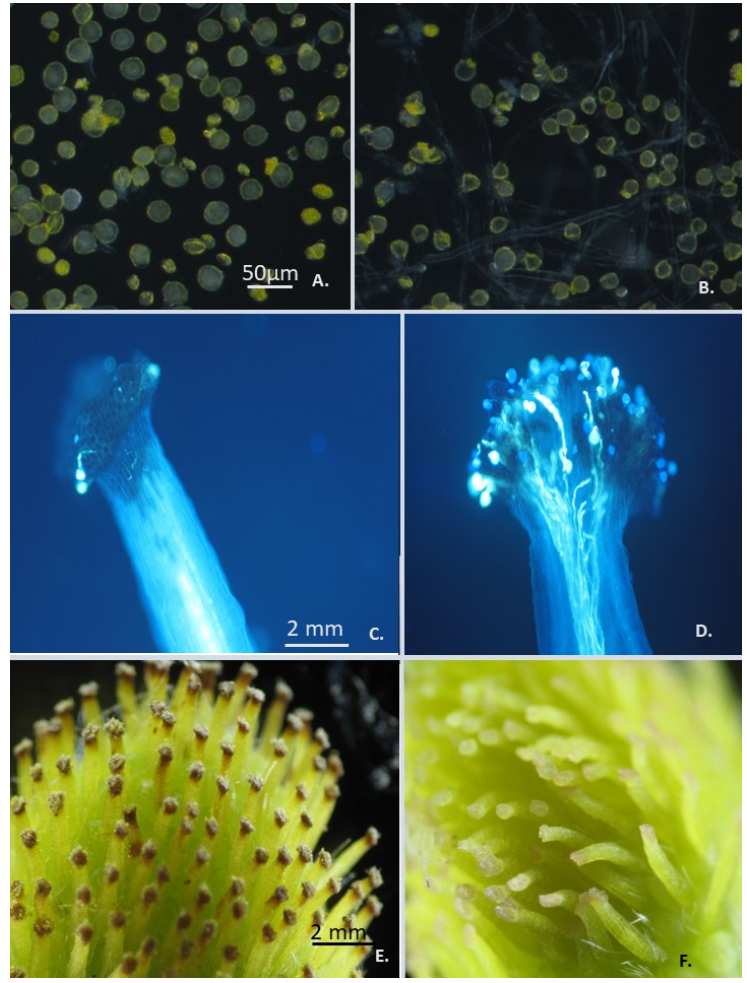
Figure 2. Pollen and stigmas of strawberry flowers collected 48 h after occurring the maximum monthly temperatures of 30 °C and 45 °C. ( A ) Non-germinating strawberry pollen (at maximum monthly temperatures above 45 °C); ( B ) germinating strawberry pollen (at maximum monthly tem- peratures below 30 °C); ( C ) single pollen grains on stigma (at maximum monthly temperatures above 45 °C); ( D ) numerous pollen grains on stigma (at maximum monthly temperatures below 30 °C); ( E ) dried stigmas in freshly opened flowers (at maximum monthly temperatures above 45 °C); ( F ) receptive stigmas in freshly opened flowers (at maximum monthly temperatures below 30 °C). 3.4. Fruit Quality The uniform shape and size of the fruits of many species is affected by the number and quality of the set seeds. This relationship also applies to most Fragaria species and, above all, cultivars [53]. In each year and in each harvest cycle (July, August, September, and October) of our experiment, all tested cultivars treated with titanium organic complex were characterized by a significantly higher number of achenes, compared to untreated plants (Table 4).